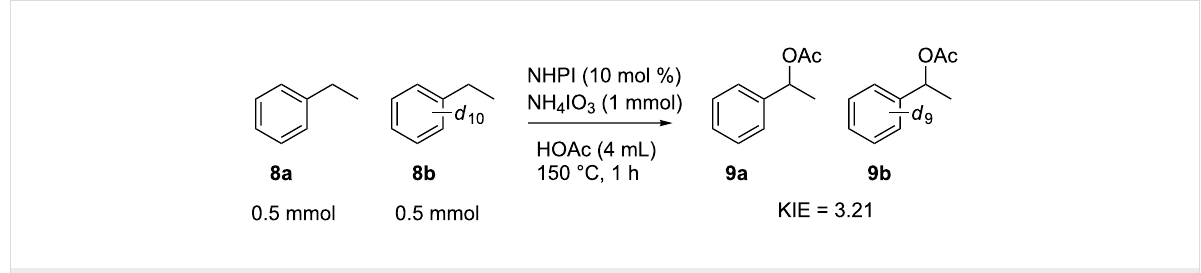
Figure 5: Competitive deuterium KIE for the oxidation of ethyl benzene by the NHPI-iodate system.